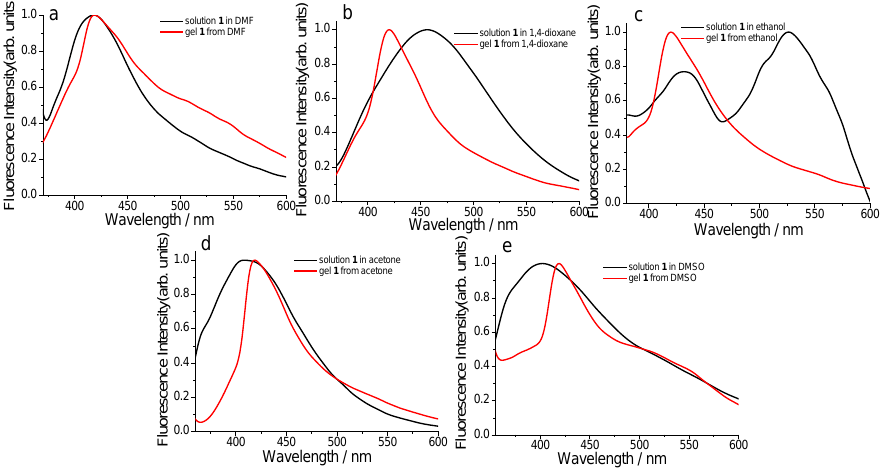
Figure 4. Fluorescence emission spectra of 1 in solution and gel state. ( a ) DMF, ( b ) 1,4-dioxane, ( c ) ethanol, ( d ) acetone, ( e ) DMSO, respectively. The concentrations of solutions were 10 −5 M and gels were at corresponding CGC.